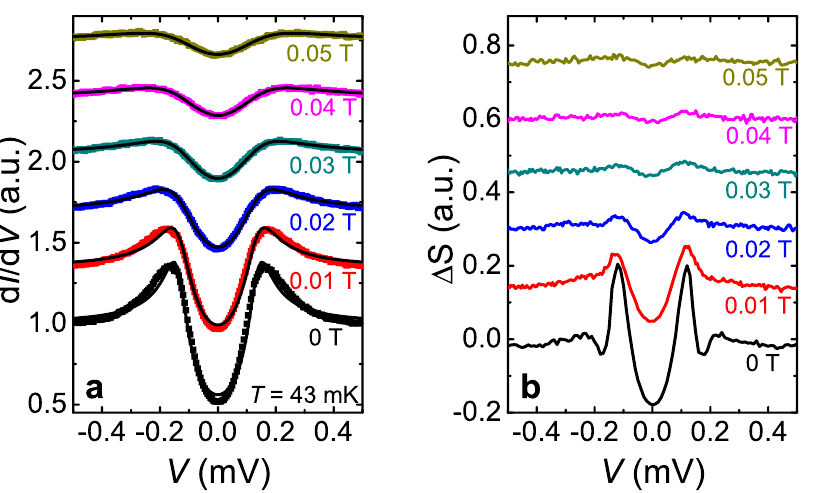
Figure 6. Magnetic field dependence of the additional gap-like feature. ( a ) Point contact spectra of the NbSe 2 /16 QL Bi 2 Se 3 heterostructure at low magnetic fields. The sample temperature is ~43 mK. Curves are shifted vertically for clarity. The black lines are BTK model fits to the experimental data. ( b ) The conductance difference between the experimental data and simulations vs. bias V at different magnetic fields. Curves are shifted vertically for